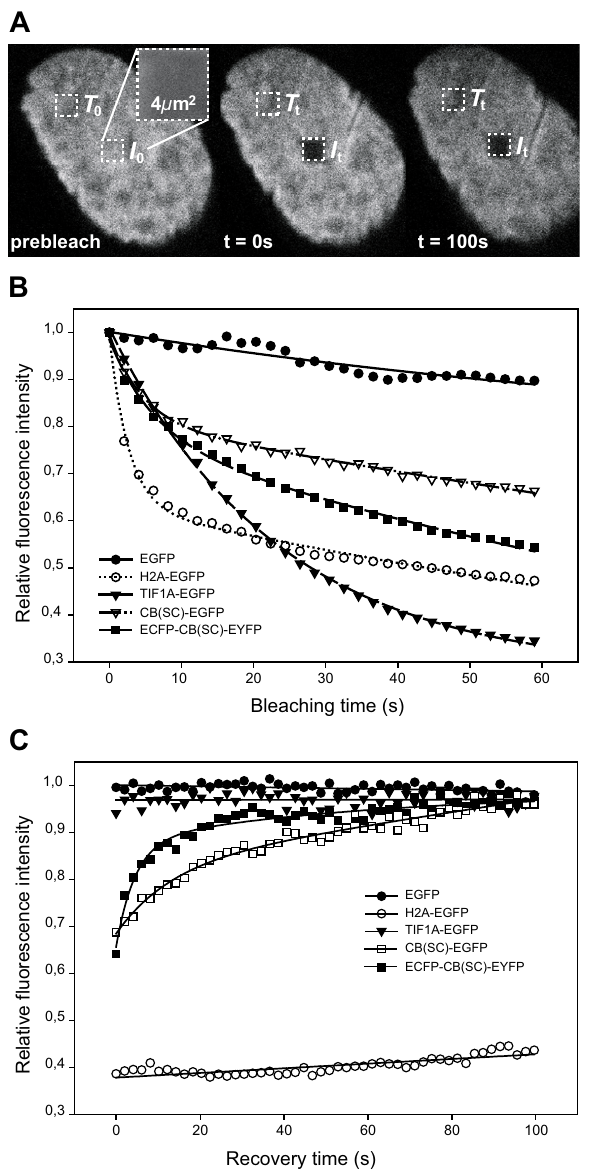
Figure 5 Nuclear diffusion and binding of recombinant CB(SC) . Fluorescence was extinguished by TPM within distinct nuclear regions and the diffusion and binding characteristics of GFP-tagged constructs were determined. A. The approach is described by means of the GFP-tagged histone-construct H2A-EGFP. In the continuous photobleaching experiment a 2 × 2 µ m 2 nuclear region was scanned consecutively and the loss of fluorescence caused by the irradiation was monitored simultaneously (see enlarged section). In the FRAP experiment, a region of same dimensions was bleached by continuous irradiation. A time series was grabbed subsequentially from a larger detail of the nucleus (first and last scan are shown). The fluorescence within the bleached region as well as in an untreated control region was measured and normalized according to equation (1). B. Continu- ous bleaching curves of CB(SC)-EGFP, ECFP-CB(SC)-EYFP as well as of the control proteins EGFP, H2A-EGFP, and TIF1A- EGFP (n = 2 or 3) are plotted as a function of time. The fitting function is composed of two partial terms and matches the val- ues sufficiently enough and more precise than a simple exponential function. The term meets the fact that there are both bound and freely diffusing fluorochrome labelled fractions. The first subterm describes the bleaching of the bound and the sec- ond one the bleaching of the diffusible component. While the graphs for EGFP and TIF1A-EGFP support free diffusion, the H2A-EGFP-population exists mostly in a bound state. Both CB(SC) constructs show an intermediate behaviour which points to bound as well as mobile fractions. C. FRAP curves of the same set of fusion proteins corroborate the findings